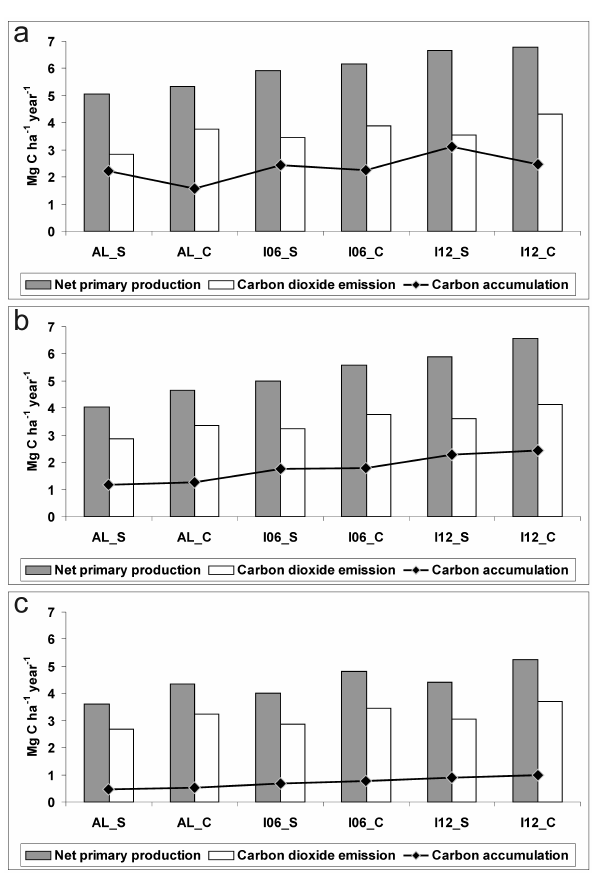
Fig. 3. Average values of NPP, emission of CO 2 , and accumulation of carbon with different levels of deposition of nitrogen compounds (AL – ambient level, I06 – increase of 6kg[N]ha − 1 yr − 1 , I12 – increase of 12kg[N]ha − 1 yr − 1 ) and climatic scenarios ( S – ambi- ent climate, C – climate change) for the different areas under study ( (a) – Dankovskoe forest area, (b) – Manturovskoe forest area, (c) – Zheleznodorozhnoe forest